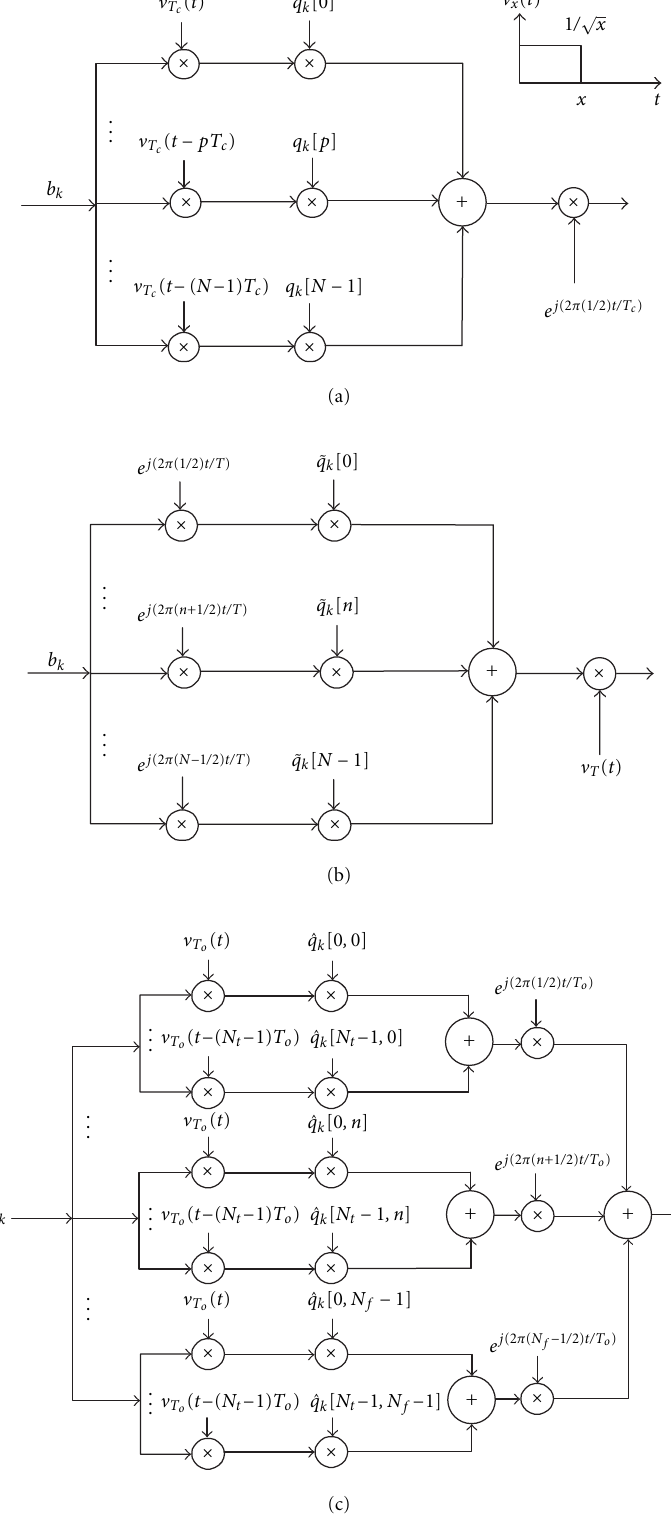
Figure 1: The transmitter structure for di ff erent CDMA systems. (a) DS-CDMA system where q k [ p ] is the p th entry of the k th user signature code. (b) MC-CDMA system where ˜ q k [ n ] is the n th entry of the k th user signature code. (c) MC-DS-CDMA system where ˆ q k [ p,n ] is the ( p,n )th entry of the k th user signature